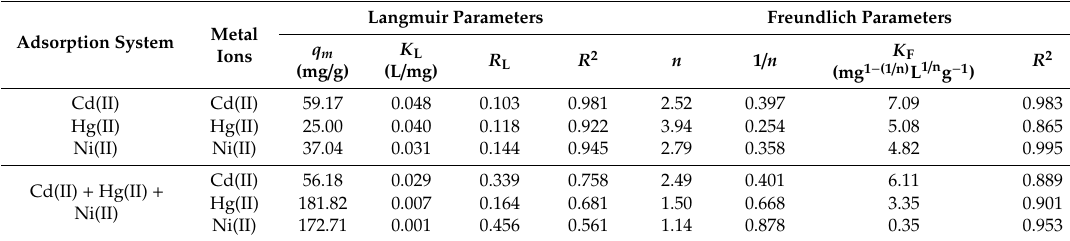
Table 3 lists the parameters of Langmuir and Freundlich isotherms models computed from the experimental tests using MAAC beads for mono-metal and ternary systems adsorption. Table 3. Langmuir and Freundlich isotherm